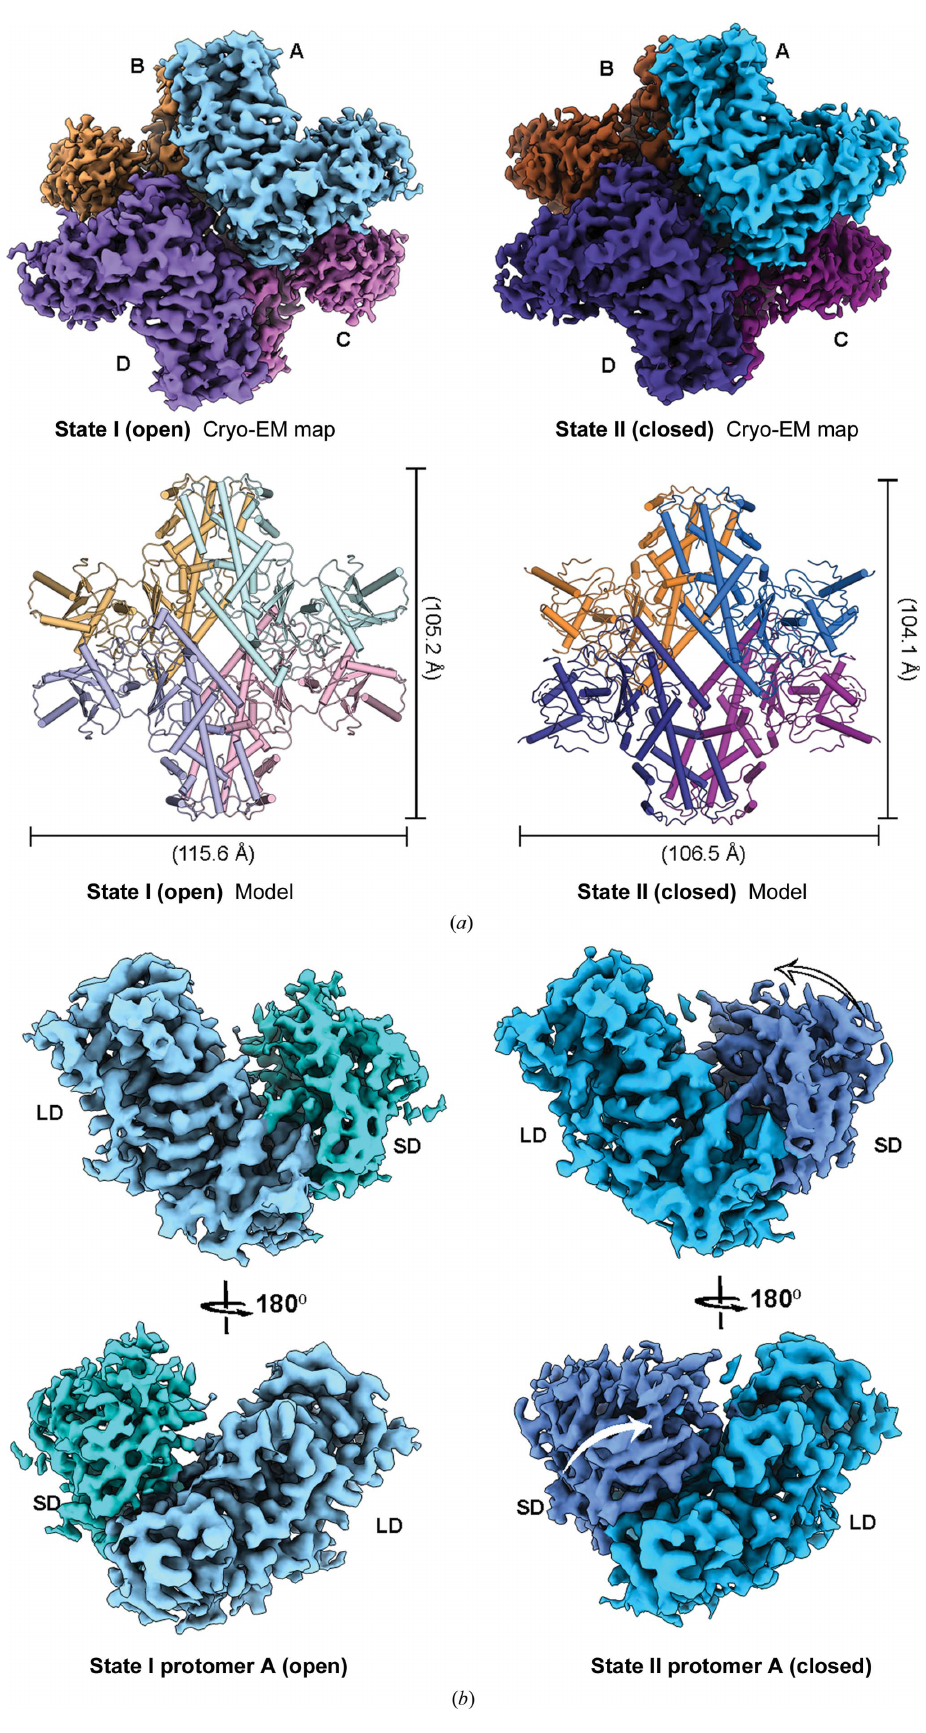
Figure 1 Overall structure of PvHK. ( a ) Cryo- EM structures of PvHK in the open (3.3 A˚ resolution) and closed (3.5 A˚ resolution) states. The corresponding models are shown in ribbon representa- tion. The structure reveals that PvHK exists as a tetramer, with four proto- mers arranged with D 2 symmetry. ( b ) Cryo-EM structures of a protomer from both the open and closed states are shown. The small domain (SD) and large domain (LD) of the protomers are highlighted with distinct